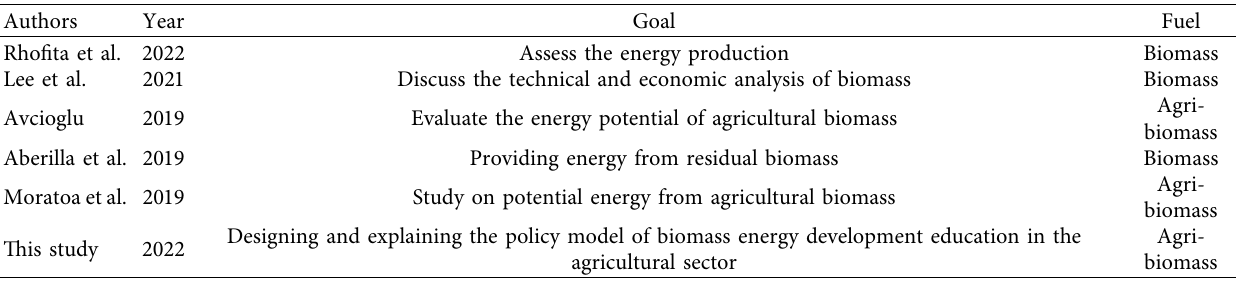
Table 1: Literature